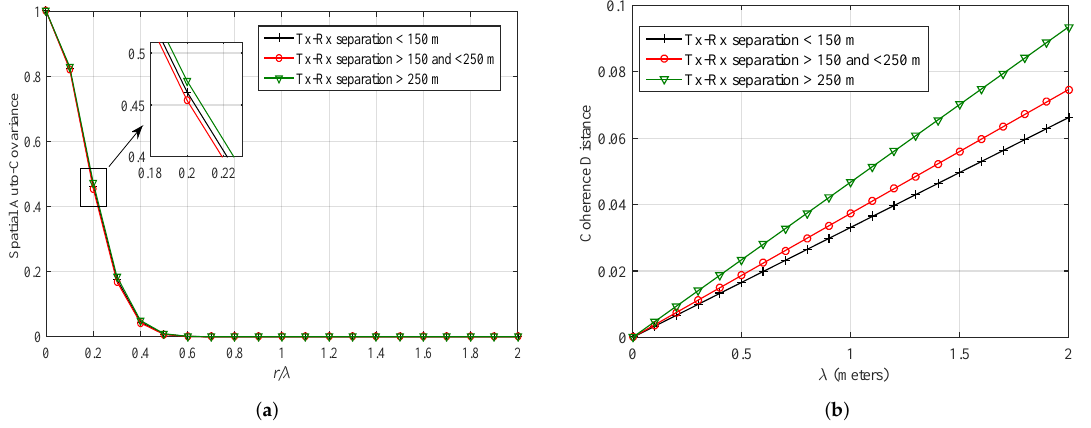
Figure 5. Spatial auto-covariance and coherence distance (CD) for different scenarios of outdoor mmWave (case 1; 38 GHz) radio propagation environments in ( a , b ), respectively. ( m = 1, f d = 1